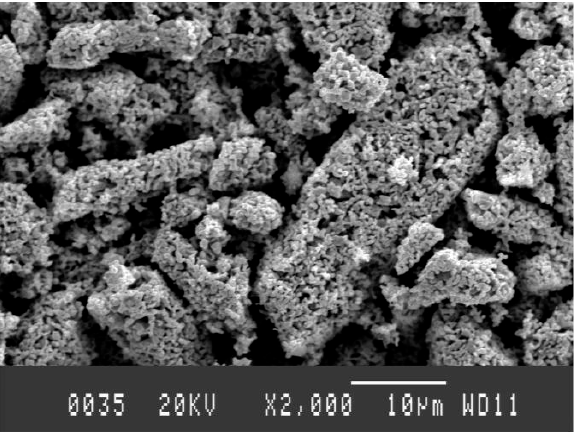
Figure 14. SEM image of 0.4 Ni/(Ni + W) molar ratio at 1173 K, magnification 2000×.